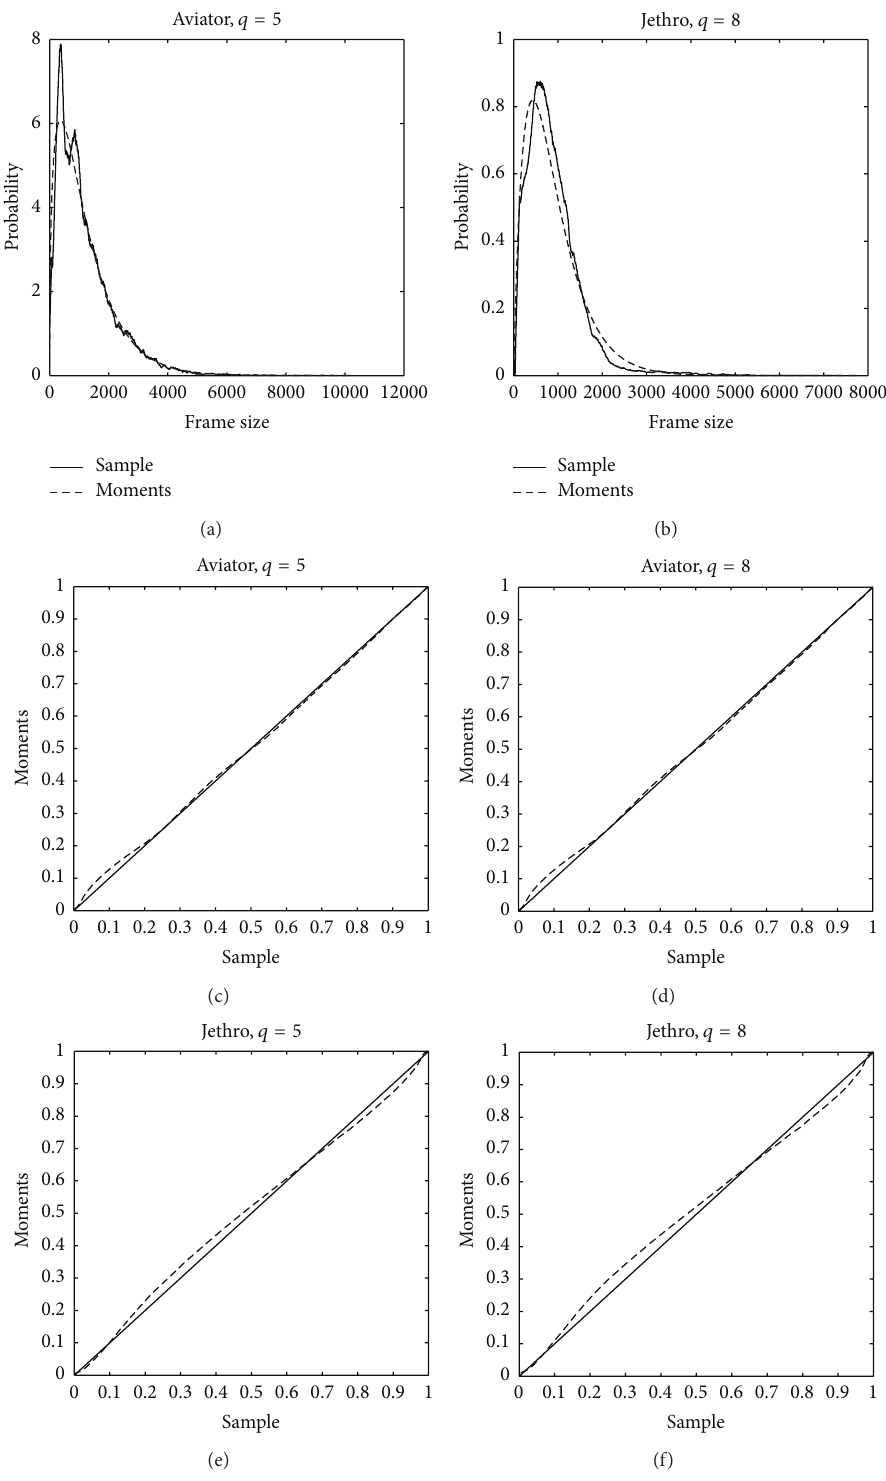
Figure 2: Frequency histograms, moments fit, and q - q